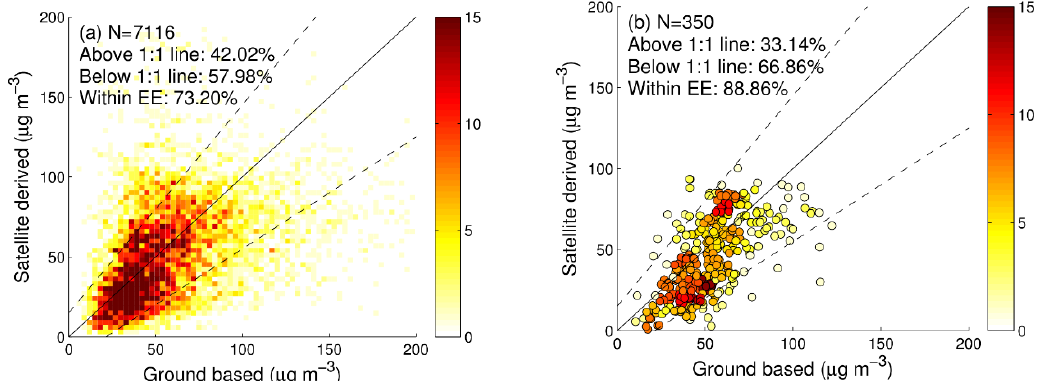
Figure 5. ( a ) Scatter density plots of monthly satellite-derived PM 2.5 versus ground-based observations binned in 3 µ g m − 3 intervals. ( b ) Comparison of the satellite-derived mean PM 2.5 with ground-based measurements, both averaged over the study period (see text), binned in PM 2.5 intervals of 8 µ g m − 3 . The color represents the number of cases (color bar). The lines are 1:1 (solid line) and the estimated error (dash lines) with ± (15 µ g m − 3 + 3